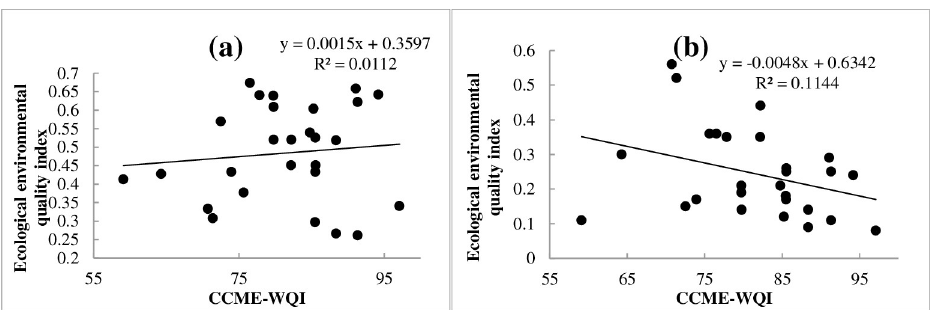
Fig 11. Correlation analysis between water quality and composite index (a-ecological environmental quality index; b-human activities quantitative index).